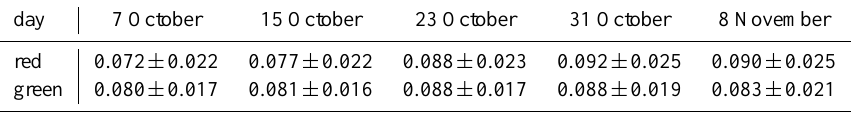
Table 2. Surface reflectance change in red and green bands from MODIS BRDF due to the vegetation change. Surface reflectance statistics (mean ± standard deviation) is calculated in the area (land surface only) centered at GSFC with 200 × 200km 2 using MODIS BRDF in red and green bands. The geometry is fixed in GOES East geometry at 18:00UTC on 7 October 2008, in order to remove the effect of the geometry change.